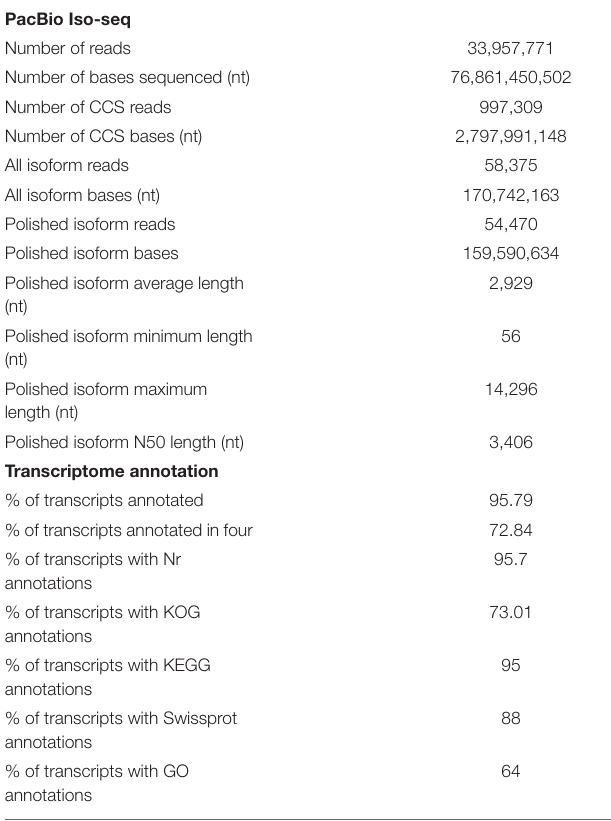
TABLE 1 | Assembly statistics for